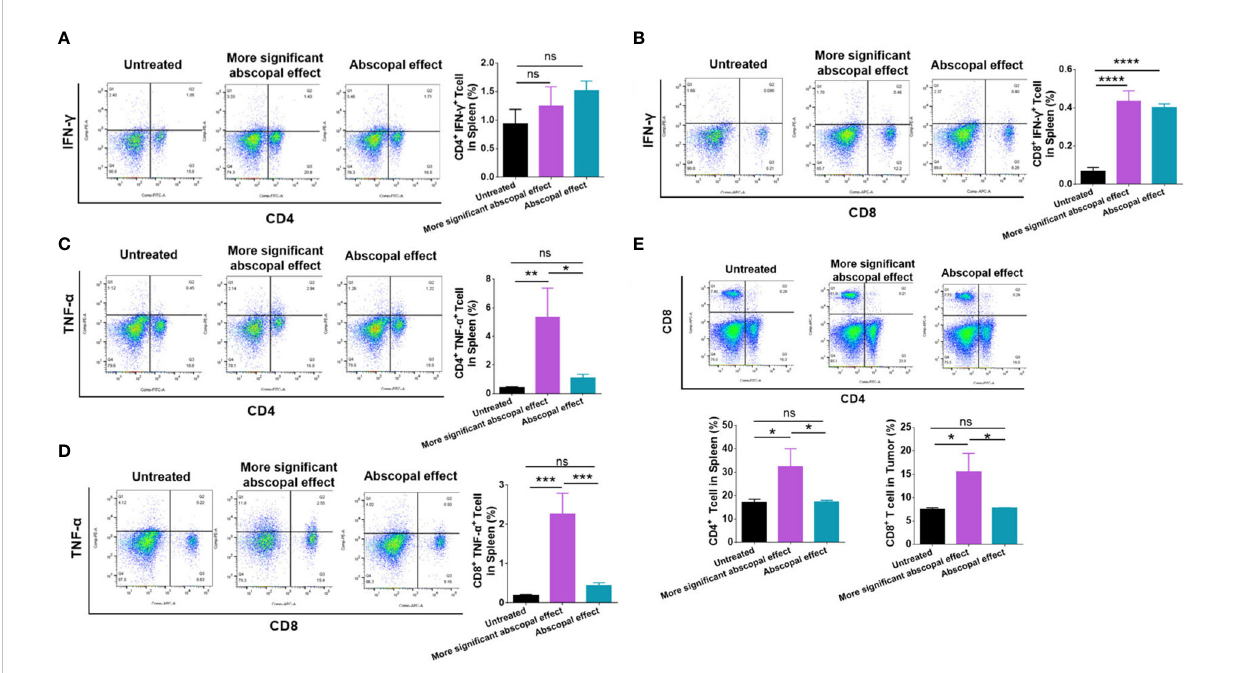
FIGURE 4 The mice presenting signi fi cant abscopal effect after MWA induced stronger systemic immune activation. The percentages of CD4 + IFN- g + T cells (A) and CD8 + IFN- g + T cells (B) in the spleen from mice presenting signi fi cant abscopal effect following MWA treatment were observed. The percentages of CD4 + TNF- a + T-cells (C) and CD8 + TNF- a + T-cells (D) in the spleen from mice presenting signi fi cant abscopal effect after MWA were 250 determined. (E) The percentages of CD4 + and CD8 + T cells in the spleen from mice presenting signi fi cant abscopal effect following MWA treatment were also identi fi ed. ns, p > 0.05; *p < 0.05; **p < 0.01. ***p < 0.001. ****p <